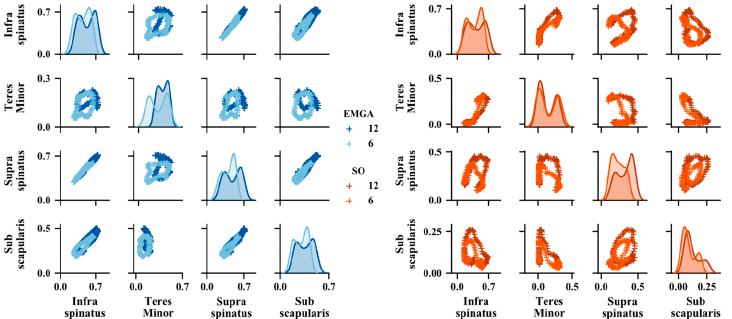
Figure 5. Activation relationships between the rotator cuff muscles as predicted for the 6 and 12 kg trials: The axes show the activation value of the respective muscles. On the diagonal: the mean distribution of a given muscle activation over the trial. In the upper (lower) triangle: the relationship between two muscles activations throughout the trial. For instance, the EMG algorithm predicted that an increase in the activation of the infraspinatus is correlated with an increase of the supraspinatus’s activation. (Mean as predicted by EMGA: right, and SO: left).